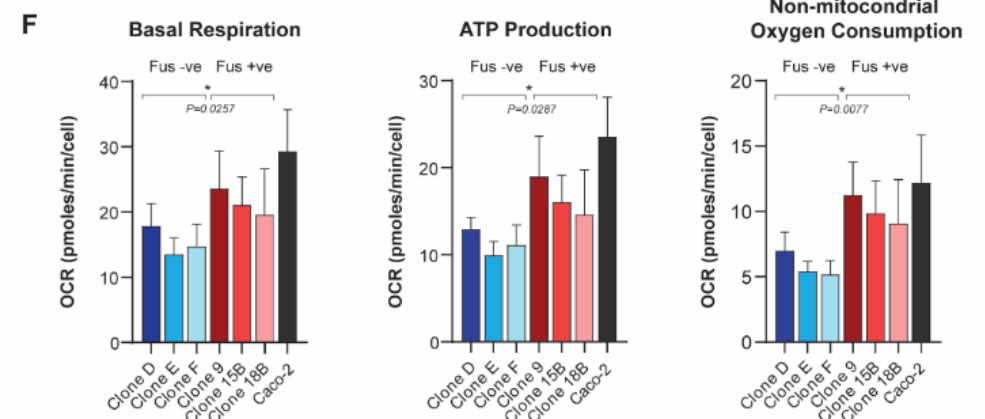
Figure 1. SLC25A40-ABCB1 fusions impair the proliferative fitness of HGSOC cells and mediate changes in drug sensitivity and metabolism. ( A ) Representative flow cytometric analysis of rhodamine 123 efflux via P-gp in AOCS18.5 SLC25A40- ABCB1 fusion-negative (Clone D) and fusion-positive (Clone 9) clones. Treatments are as follows: 4 °C (green, P-gp inactive), 37 °C with ABCB1 competitive substrate Vinblastine (VIN) (pink), and 37 °C DMSO (pink, P-gp active). ( B ) IncuCyte proliferation analysis of AOCS18.5 parental (black), fusion-negative (blue) and fusion-positive (red) clones over 216 h. Dashed line denotes 50% confluency. ( C ) Correlation between total ABCB1 mRNA expression and time to reach 50% confluency in fusion-negative (blue) and fusion-positive (red) clones. ( D ) Absolute fitness of fusion-negative and positive clones according to intrinsic growth rate. ( E ) Relative viability (IC 50 ) of fusion-negative and positive cells following 72 h treatment with P-gp substrate (doxorubicin, paclitaxel) and non-substrate (cisplatin) therapy. Viability assessed via DAPI staining. ( F ) Basal respiration, ATP production and non-mitochondrial oxygen consumption rate of fusion-negative and positive clones evaluated through oxygen consumption rate (OCR) analysis (Seahorse extracellular flux assay). Data normalized to cell number. Caco-2, a known ABCB1 overexpressing colon carcinoma cell line ( SLC25A40-ABCB1 fusion-negative). Data represents mean ± SEM from a minimum of 3 independent experiments. Asterisks denote statistical significance * p < 0.05, ** p < 0.01, *** p < 0.001.